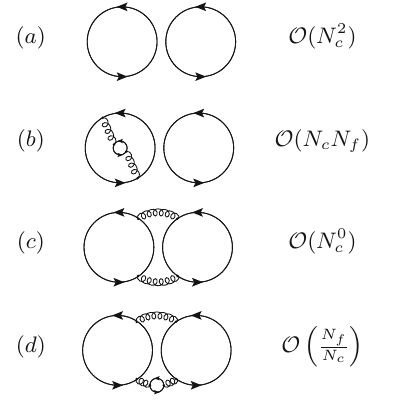
Fig. 2 N c , N f scaling of various contributions to the colour- disconnected contraction, corresponding to the O suud ( x ) insertion